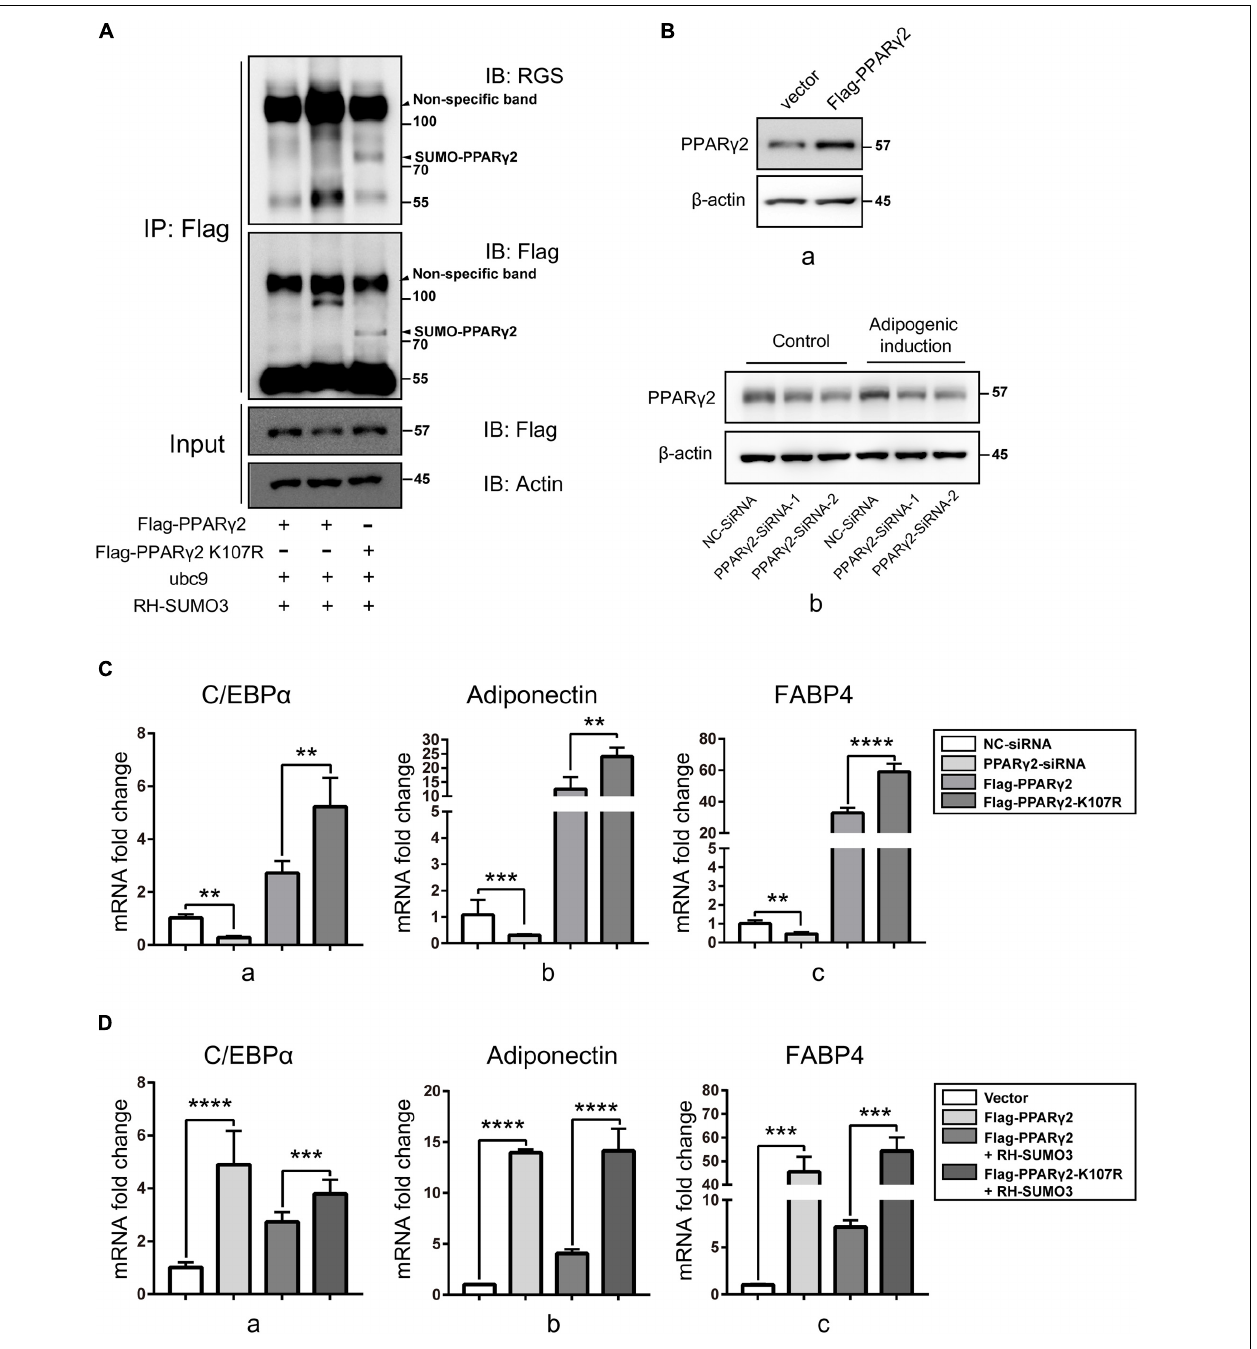
FIGURE 6 | The SUMOylation reduced the activity of PPAR γ 2 through K107 site and weakened adipogenic differentiation. (A) The SUMOylation of PPAR γ 2 was relied on Lys residues of 107 and 395. Flag-PPAR γ 2, Flag-PPAR γ 2-K107R, ubc9 and RH-SUMO3 were co-expressed in HEK293T cells and co-IP assays were performed with Flag and RGS antibody. (B) The expression of PPAR γ 2 in ST2 cells transfected by Flag-PPAR γ 2 for 24h (a) and NC-siRNA and PPAR γ 2-siRNA for 36 h (b) were detected by Western Blot. (C) NC-SiRNA, PPAR γ 2–SiRNA, Flag-PPAR γ 2, and Flag-PPAR γ 2-K107R were transfected in mouse mesenchymal stromal cell line ST2 cells and the expression of adipogenic marker genes C/EBP α (a) , adiponectin (b) , and FABP4 (c) was analyzed by Q-PCR after 7-day adipogenic induction. (D) Flag-PPAR γ 2, Flag-PPAR γ 2-K107R, and RH-SUMO3 were transfected in ST2 cells and the expression of adipogenic marker genes C/EBP α (a) , adiponectin (b) , and FABP4 (c) was analyzed by Q-PCR after 7-day adipogenic induction. Data are shown as the mean ± SEM. ** p < 0.01, *** p < 0.001; **** p < 0.0001. All the data were obtained from at least three independent experiments.